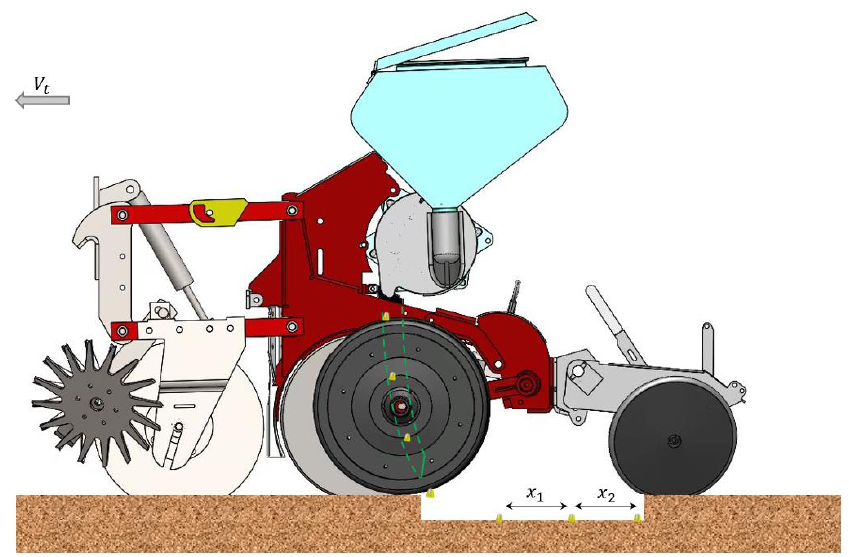
Figure 1. Real-time seeding spacing measurement for seeder seeding. “ V t “: forward speed of the Figure 1. Real- time seeding spacing measurement for seeder seeding. “ 𝑉 t “: forward speed of the seeder, seeder, km/h.